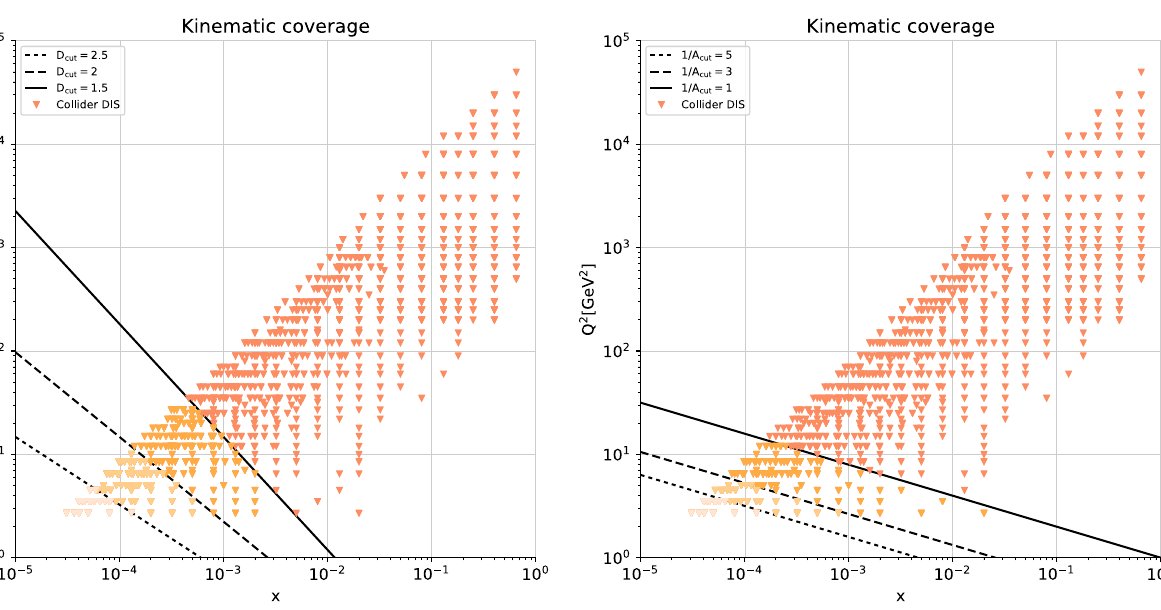
inspired cut Eq. (5.2); right plot: saturation-inspired cut Eq. (5.4). Note that the data points affected by the various cuts are plottedwith different